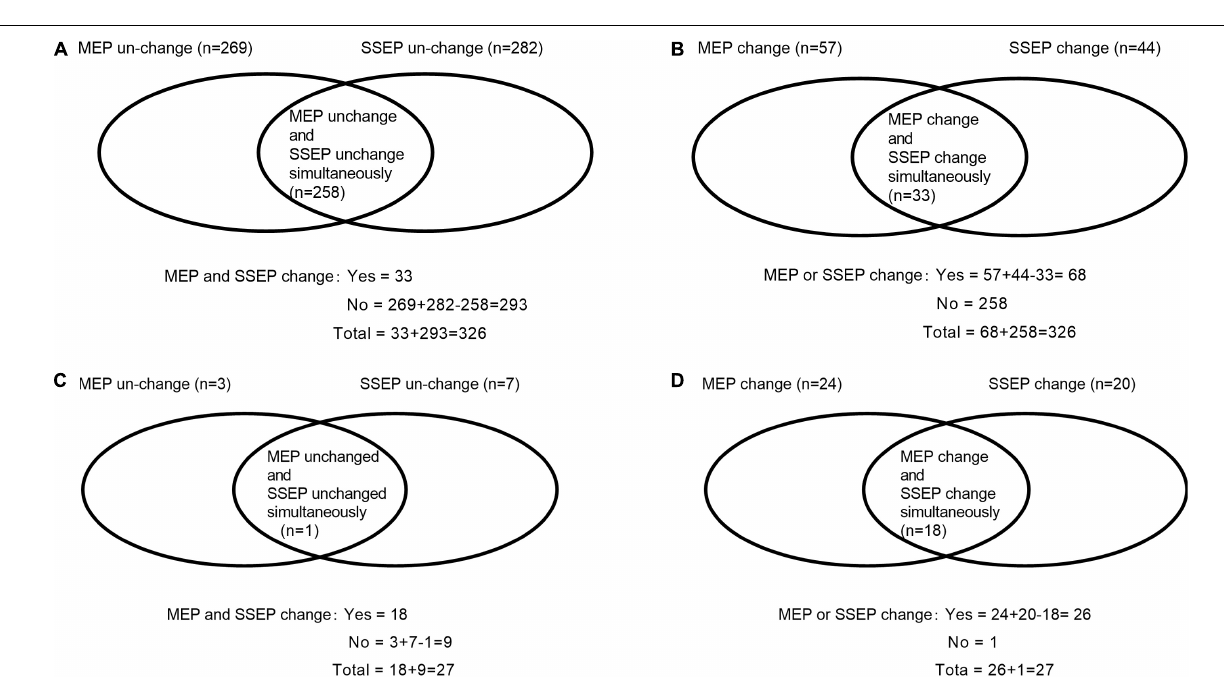
Frontiers in Neuroscience |